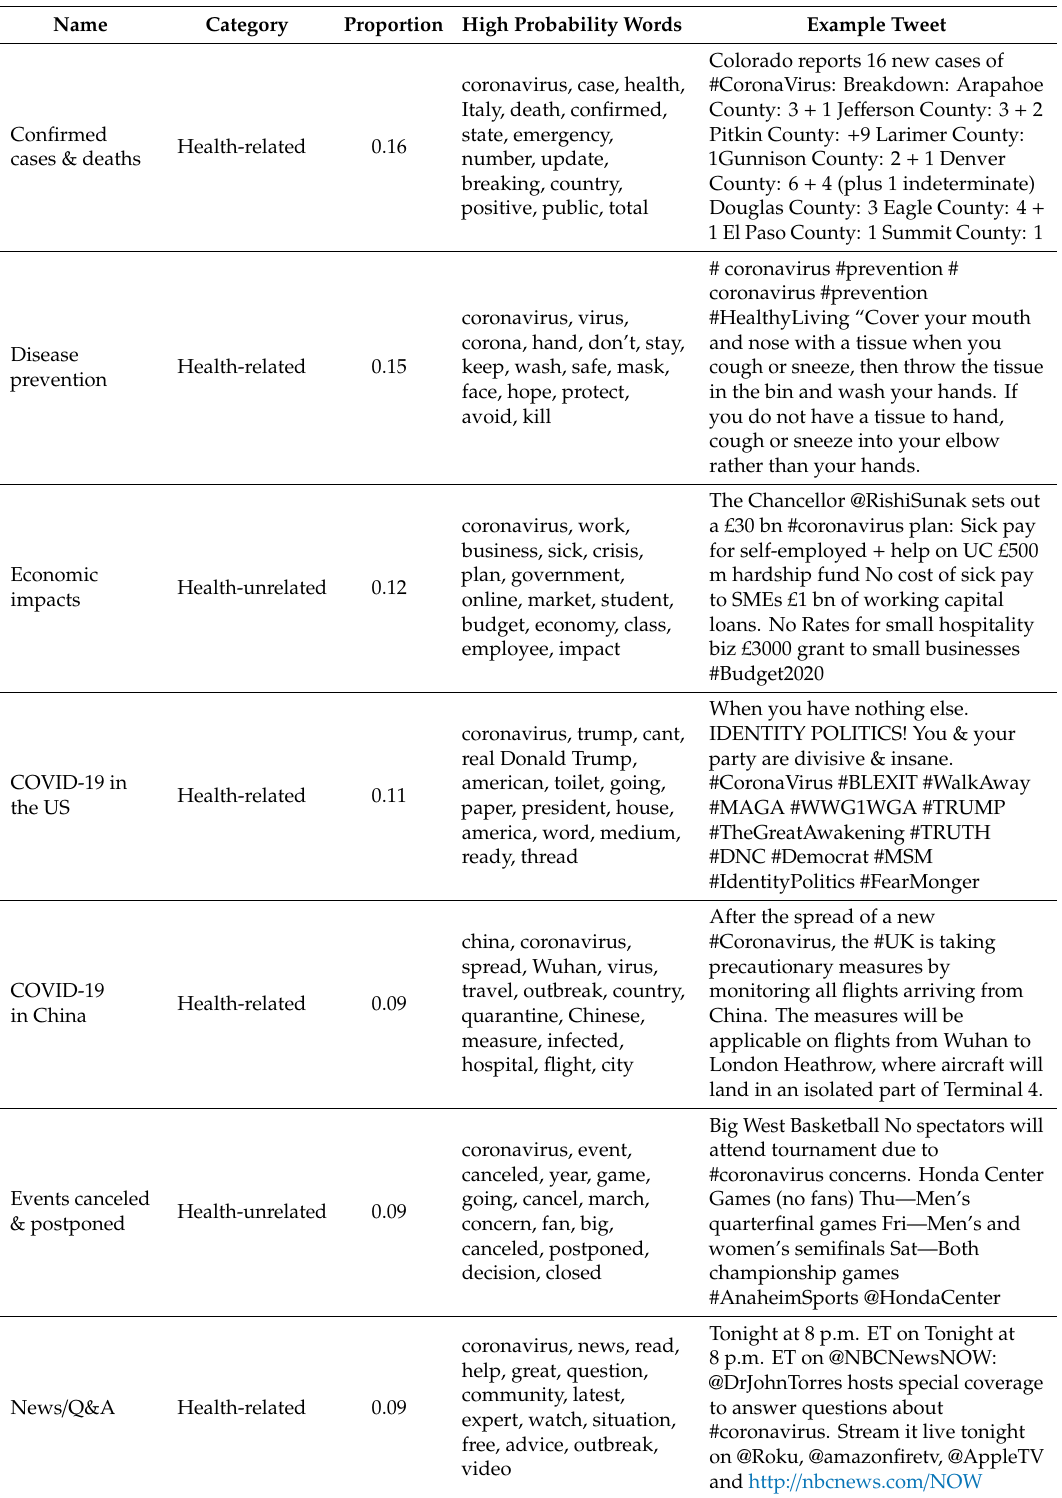
Table 1. List of 12 tweet topics according to the structural topic